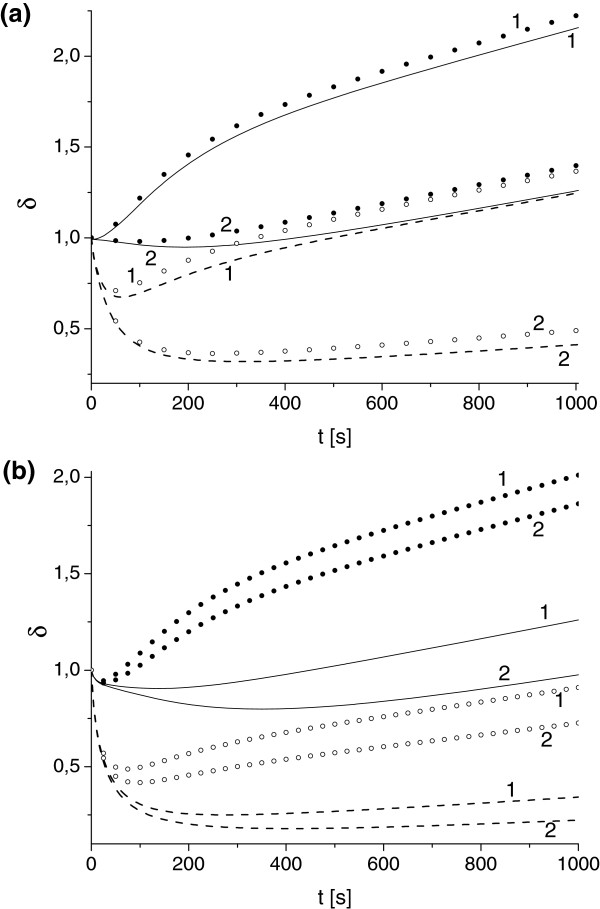
Effect of variation of toxin advection velocity v on parameterδ. Advection-diffusion models (solid lines): v=0.001, γ=0.01 (1), v=0.001, γ=0.1 (2), v=0.05, γ=0.01 (3), v=0.05, γ=0.1 (4); toxin diffusivity: (a)κT=10-3, (b)κT=10-4. Well-mixed models (dashed lines): γ=0.01 (1), γ=0.1 (2).